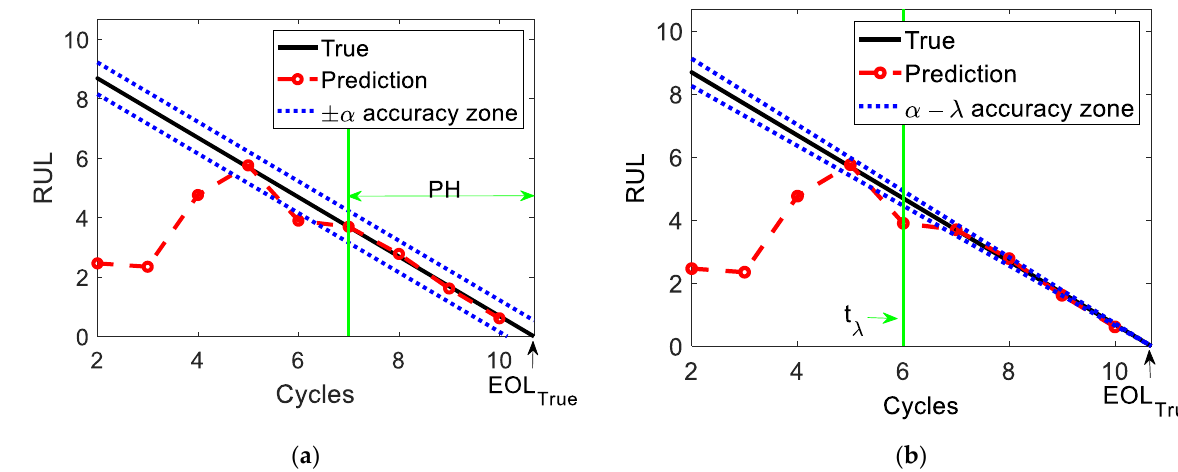
Figure 4. Illustration of prognostics metrics. ( a ) Prognostic horizon (PH), ( b ) α − λ accuracy.